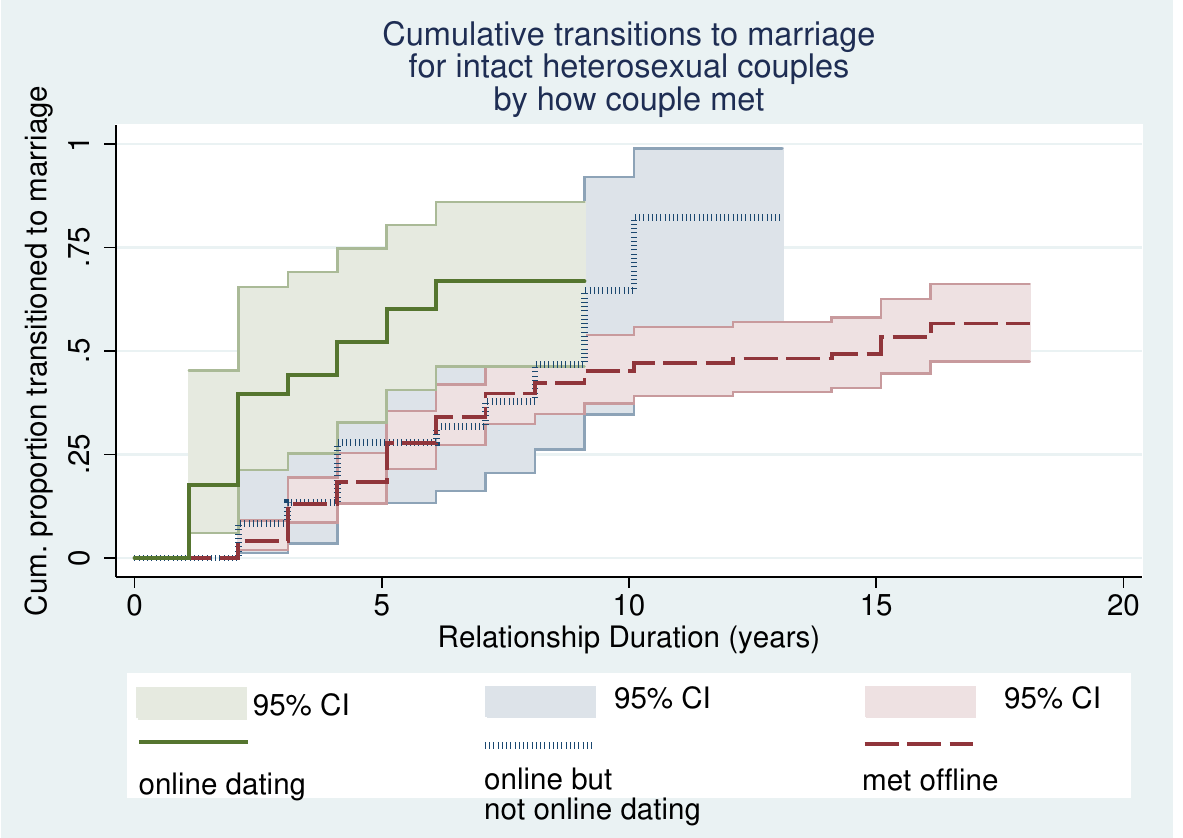
Figure 2: Meeting through Internet dating associated with faster transitions to marriage. Source: HCMST prospective data. Unweighted cumulative transitions to marriage in 2009 to 2015 (with 95 percent confidence intervals) for intact heterosexual couples who were unmarried at HCMST wave 1. Cumulative transitions to marriage is 1 – S, where S = (Kaplan–Meier survival curve for remaining unmarried). The number of transitions to marriage was 13 for heterosexual couples who met through online dating, 12 for heterosexual couples who met online but not through online dating, and 84 transitions to marriage for heterosexual couples who met